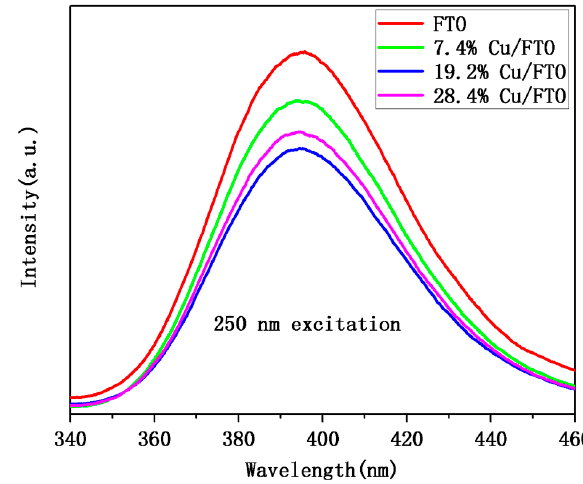
Figure 7. PL (photoluminescence) spectra of FTO and Cu/FTO samples with different contents of Cu.